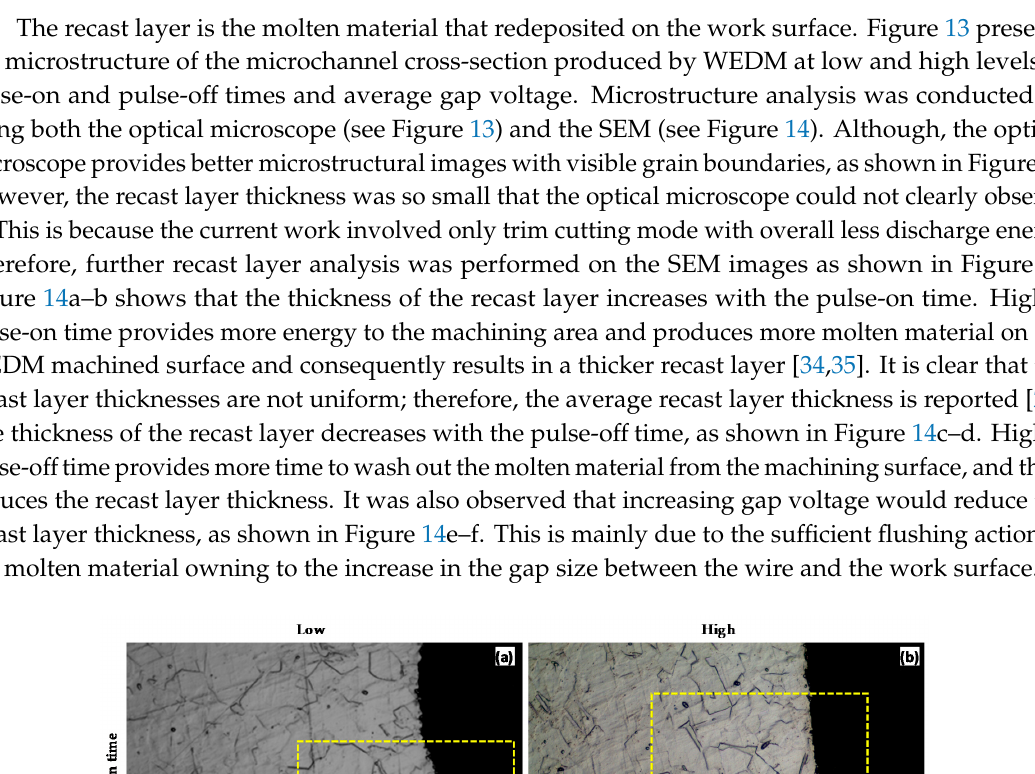
Figure 12. Subsurface microhardness at ( a ) low and high TON ( b ) low and high TOFF ( c ) low and high VGAP.